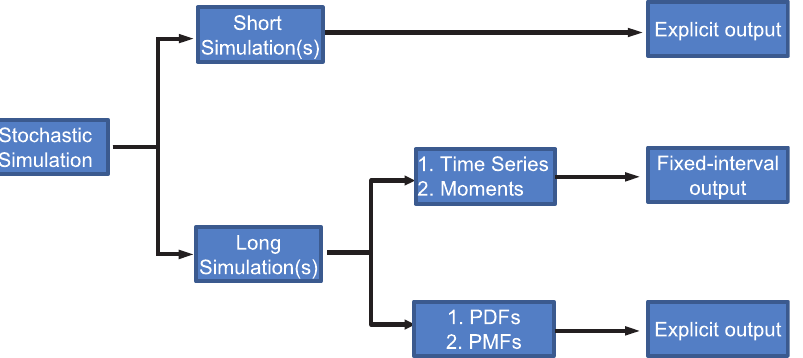
Figure 8. Stochastic modeling Decision Tree. Both fixed-interval and explicit output have their advantages and disadvantages. The decision whether to use fixed-interval or explicit output depends on the type of